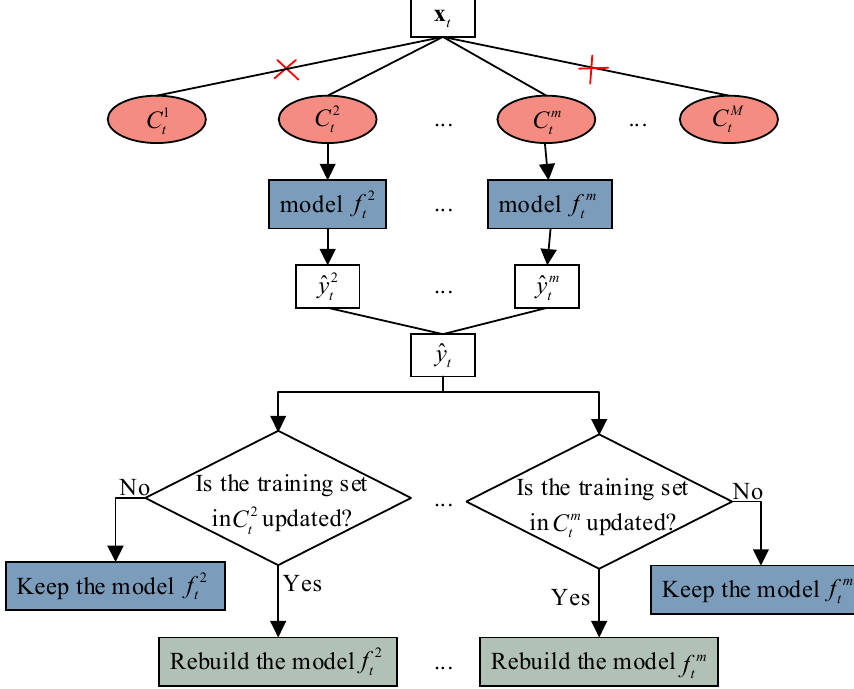
Figure 1. Schematic diagram of adaptive selective ensemble learning